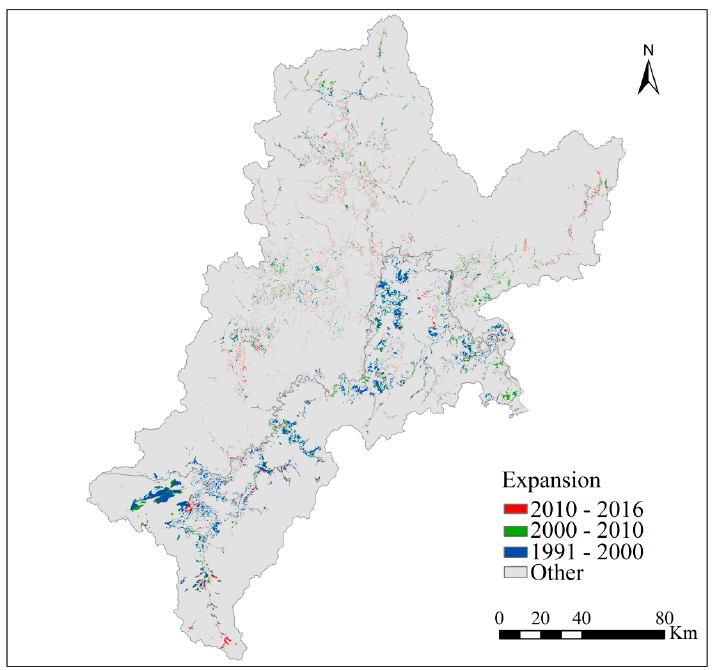
Figure 5. Spatial pattern of farmland expansion across different regions over the three times.